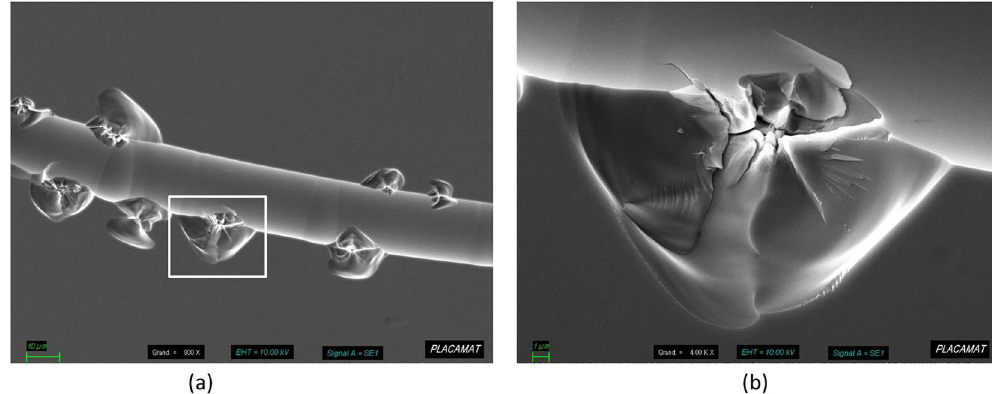
Figure 10. Laser damage initiation on a 12 µ m wet etched scratch at 18.7 J/cm², 355 nm, 3 ns. Multiple damage sites are triggered at the edge of the scratch, were field enhancement is maximum ( a ). Close-up view of the area in the square, showing the melted region suggesting field initiation from within the fused